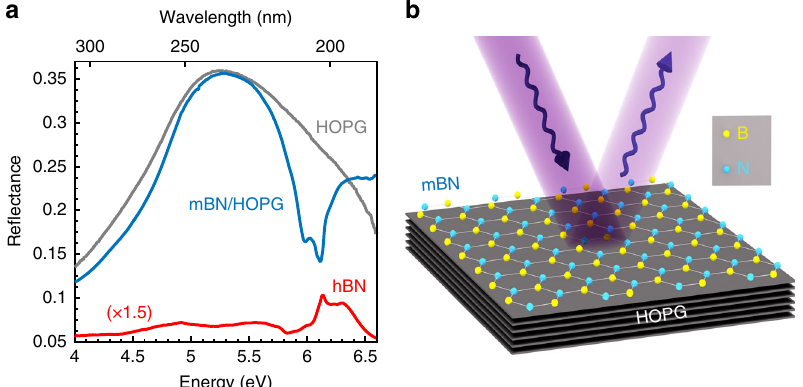
Fig. 2 Re fl ectance of epitaxial monolayer BN on graphite. a Re fl ectance spectrum in the deep ultraviolet for the bare graphite substrate (grey line), mBN on graphite (blue line), and bulk hBN (red line), at 10 K. b Schematic of the re fl ectance experiment performed on the mBN-graphite heterostructure synthesised by van der Waals epitaxy. HOPG stands for highly oriented pyrolytic graphite